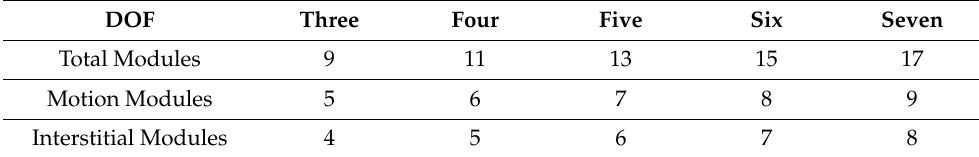
Table 4. Robotic configuration module parameters.